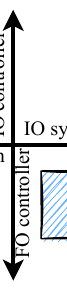
Figure 5. Possible combinations for integer-order (IO) and fractional-order (FO) approaches for the system-controller duo when introducing Fractional Calculus into Control